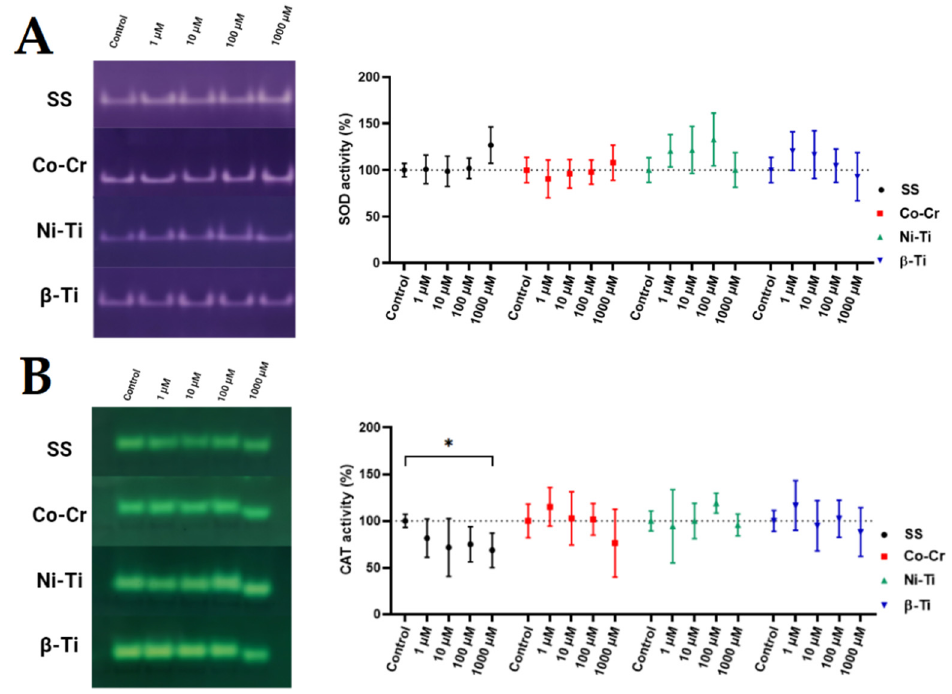
Figure 3. In-gel antioxidative activity of SOD ( A ) and CAT ( B ) enzyme after metal ion mixture treatment. The most representative images are shown ( n = 5). Statistically different results in the graph are labeled with * (* p < 0.05).